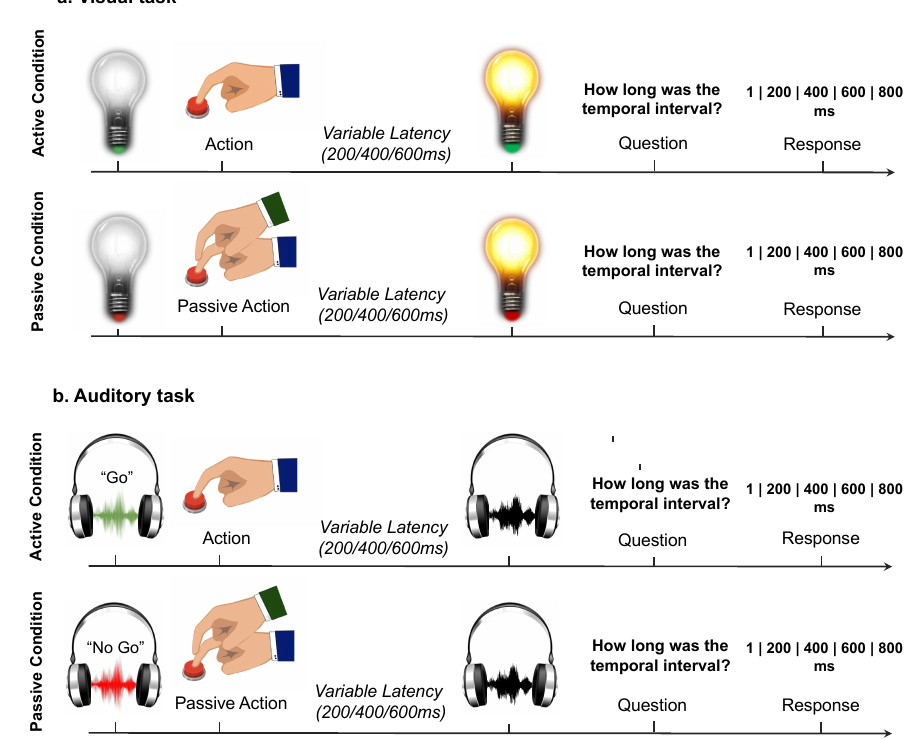
Figure 1. Experimental task. Graphical illustration of an experimental trial (for both active and passive conditions) for the visual ( a ) and the auditory ( b ) tasks. During the active trials, participants pressed a button with their right index finger at their own time after the presentation of the cue. In the passive trials, participants were instructed to stay still while an experimenter pressed their finger to produce a passive movement. In both conditions, the button press caused an action-consequence: the lightening of the lightbulb in the visual task, a pure tone in the auditory task. The consequence was presented after a variable delay of 200, 400 or 600 ms. Participants then judged the perceived time interval between their button press and the action-consequence (the lightening of the lightbulb or the tone).